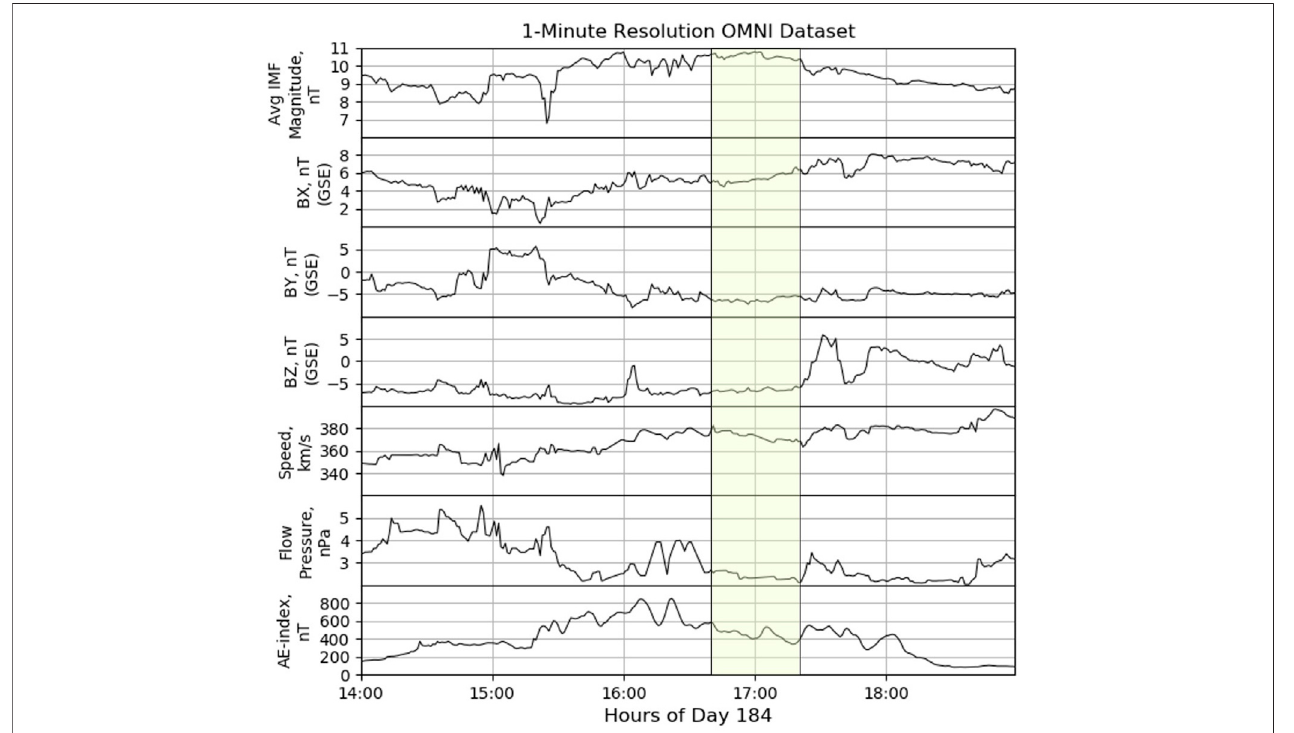
FIGURE 2 | OMNI derived solar wind parameters for July 3, 2007 from 1400 to 1900 UT. The highlighted portion represents the time frame of the observed KHI from 1640 to 1720. From top to bottom: average IMF magnitude, nT; B X , nT; B Y , nT; B Z , nT; speed, km s − 1 ; fl ow pressure, nPa; and AE index,